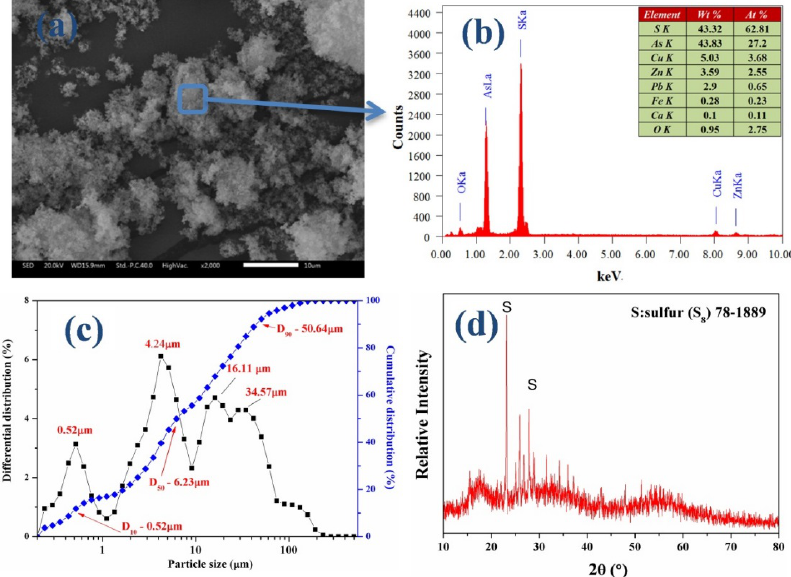
Figure 1. Characterization of the raw HB-ASR: ( a ) SEM; ( b ) EDS; ( c ) Particle size distribution; and ( d ) X-ray diffraction pattern.